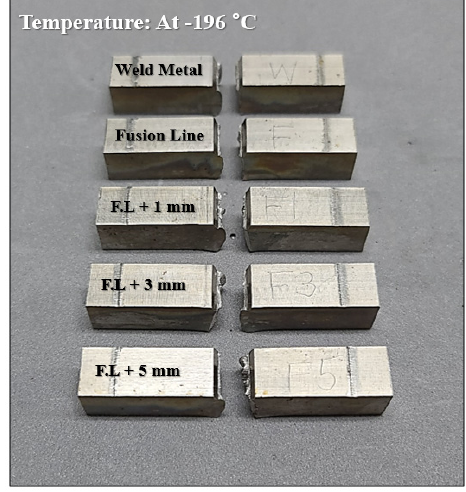
Figure 6. Fractured specimen after the low-temperature impact test.